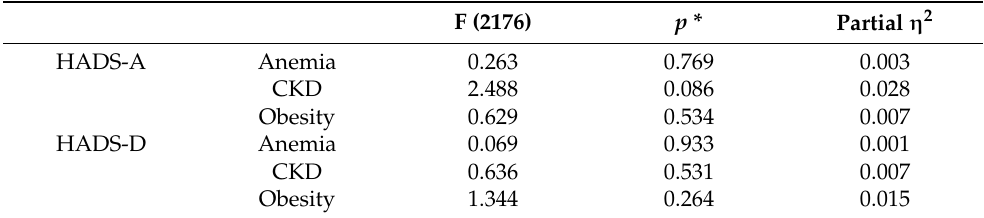
Table 6. Two-way mixed ANOVA analysis for comorbidities interaction with HADS scores’ evolution over time.